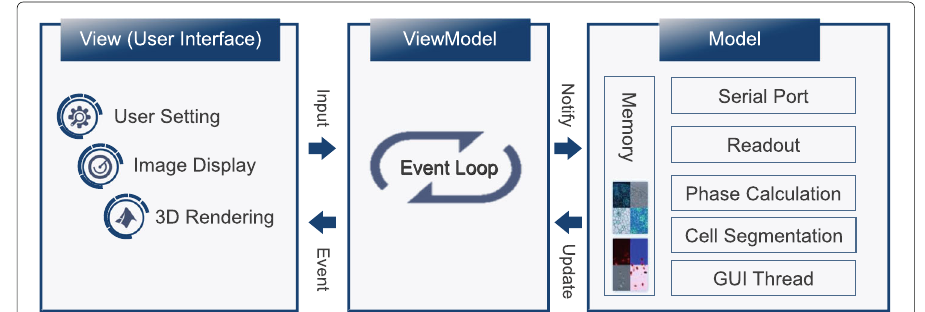
Fig. 31 Model-View-ViewModel (MVVM) framework mode